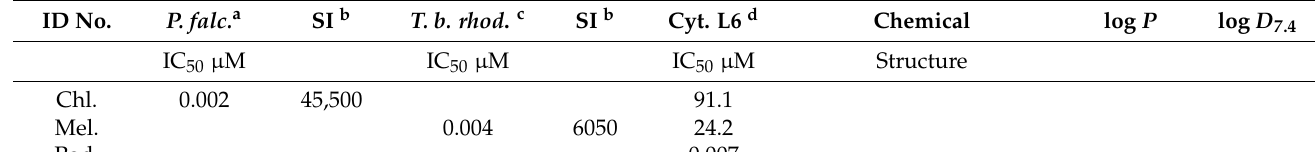
Table 2. In vitro antiparasitic activity, host toxicity and key physicochemical properties of the tested compounds.